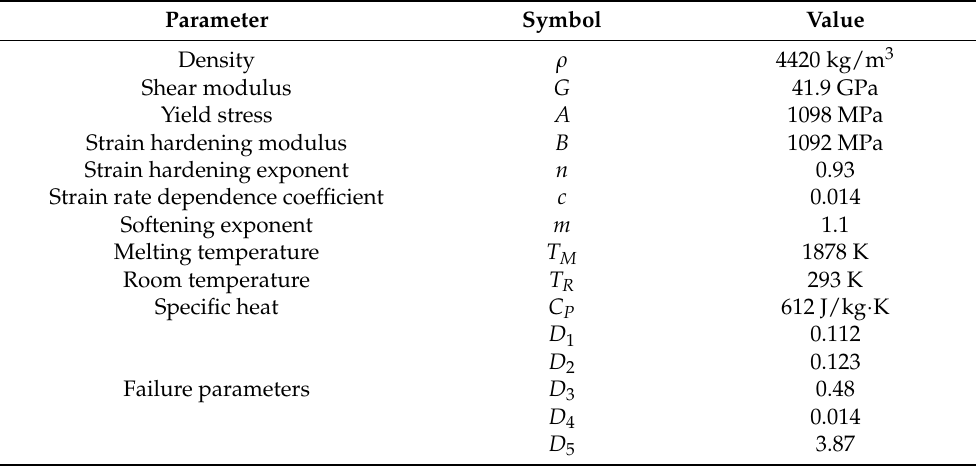
Table 3. Johnson–Cook material parameters for Ti-6Al-4V used in the simulation [32]. Parameter